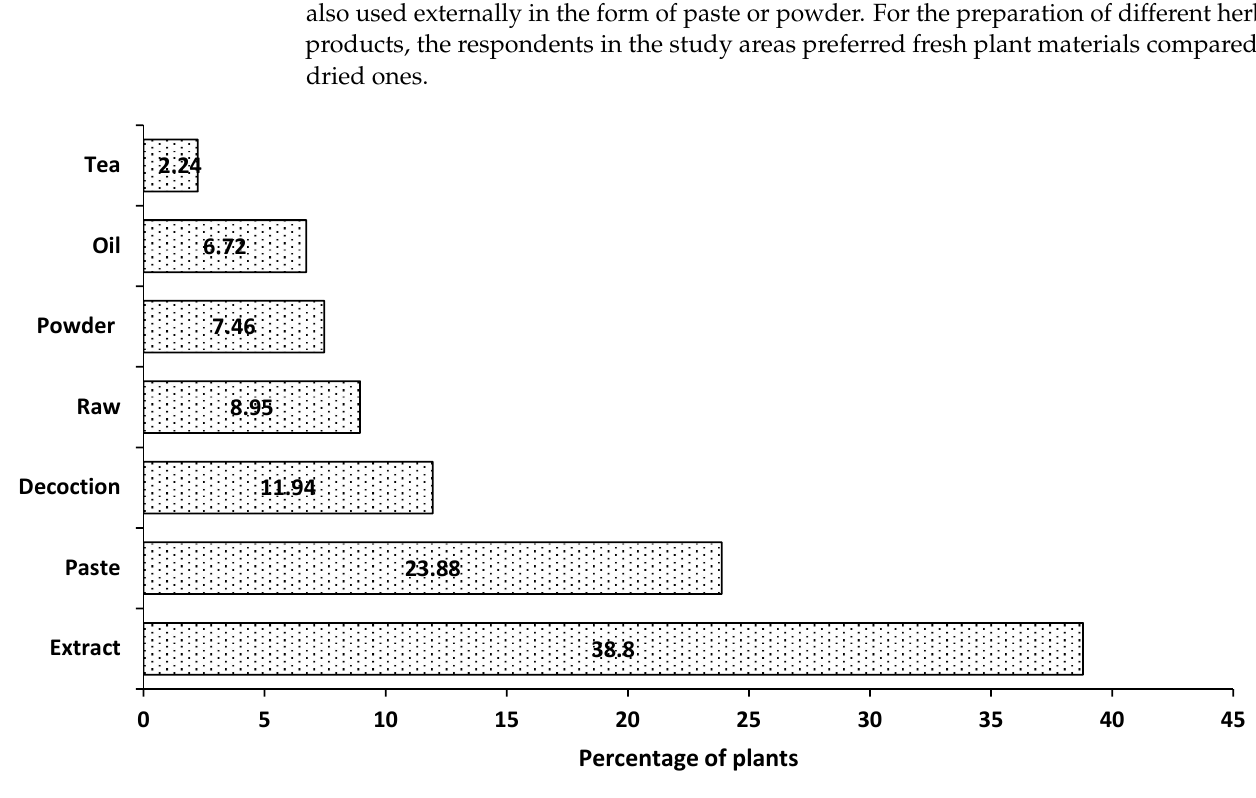
Figure 4. Mode of Figure 4. Mode of administration.